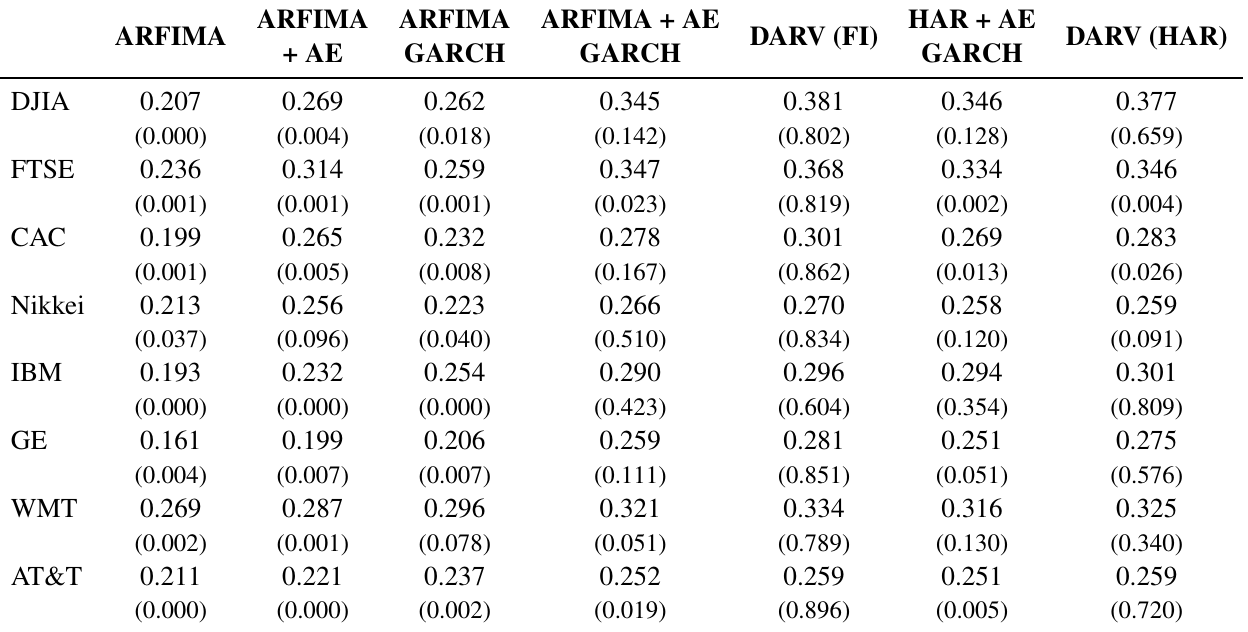
Table 8. Forecasting results: other